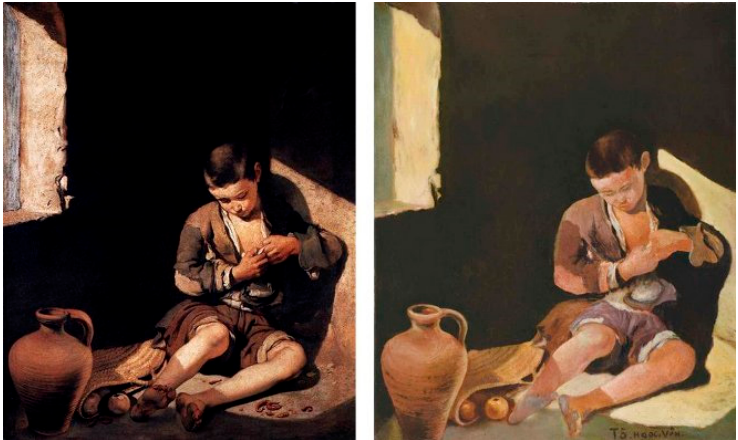
Figure 8. The young beggar ( Left ) and Mo ve mot ngay mai ( Right with signature). The image was sourced from The Thao & Van Hoa Newspaper (Diep 2017b).